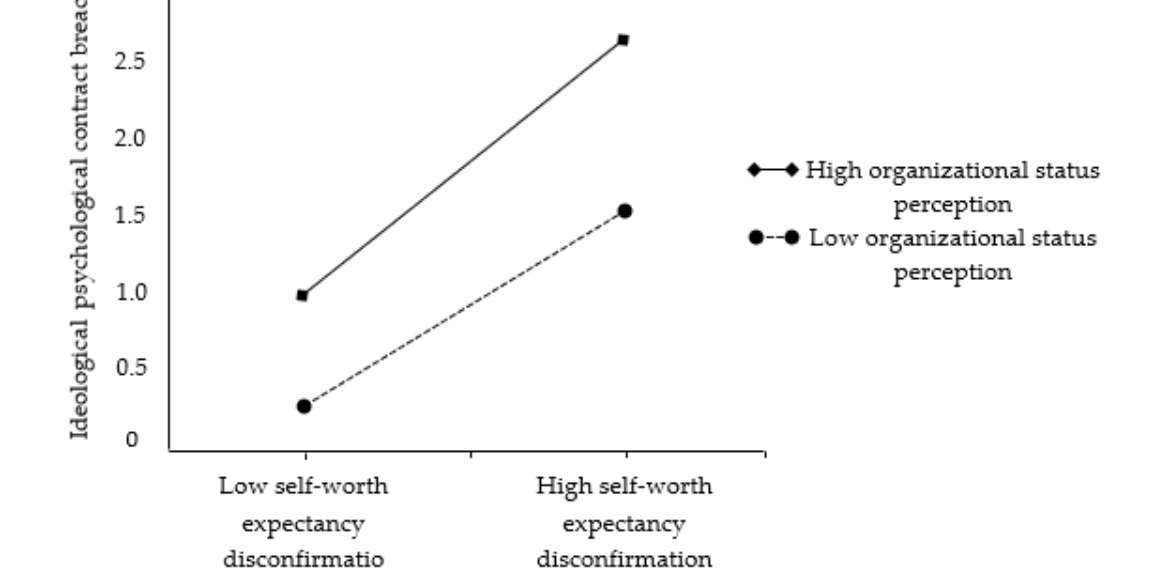
Figure 2. Moderating effect of perceived organizational status. Table 10. Results of path coefficients and hypotheses